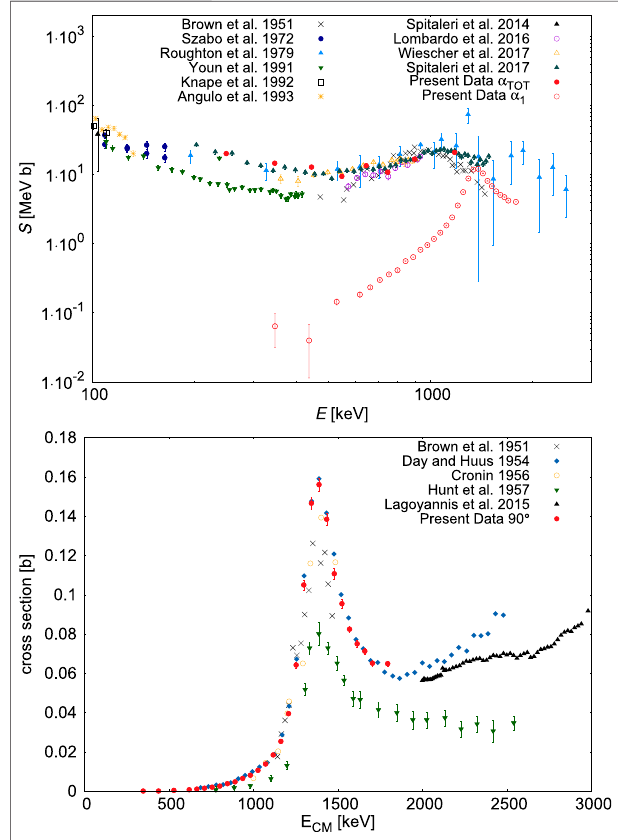
FIGURE 6 | Upper panel: Total astrophysical S(E)-factor for the 10 B(p, α ) 7 Be reaction. Lower panel: Cross section for the 10 B(p, α 1) 7 Be reaction